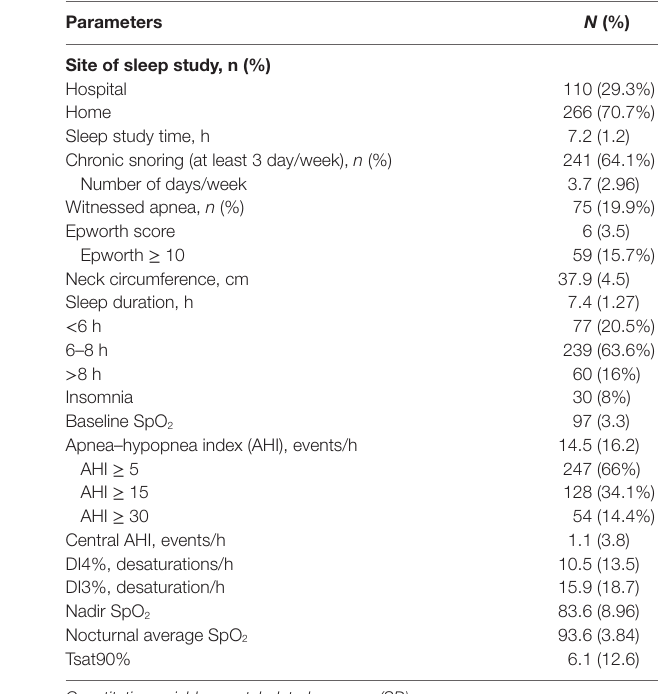
TaBle 2 | Sleep characteristics and other comorbidities.